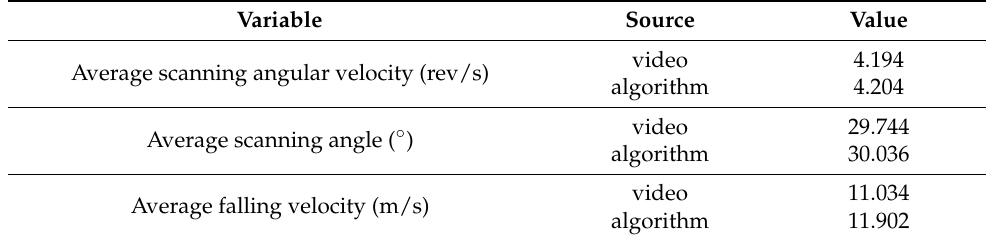
Table 1. The comparison of video data and solution